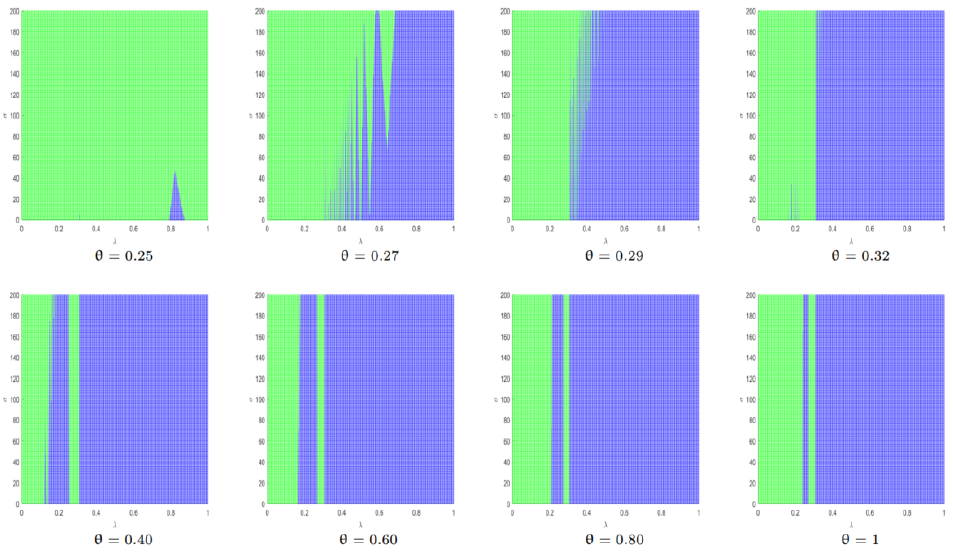
Figure 19. Platform profit competition in Model B with the combination of λ and σ